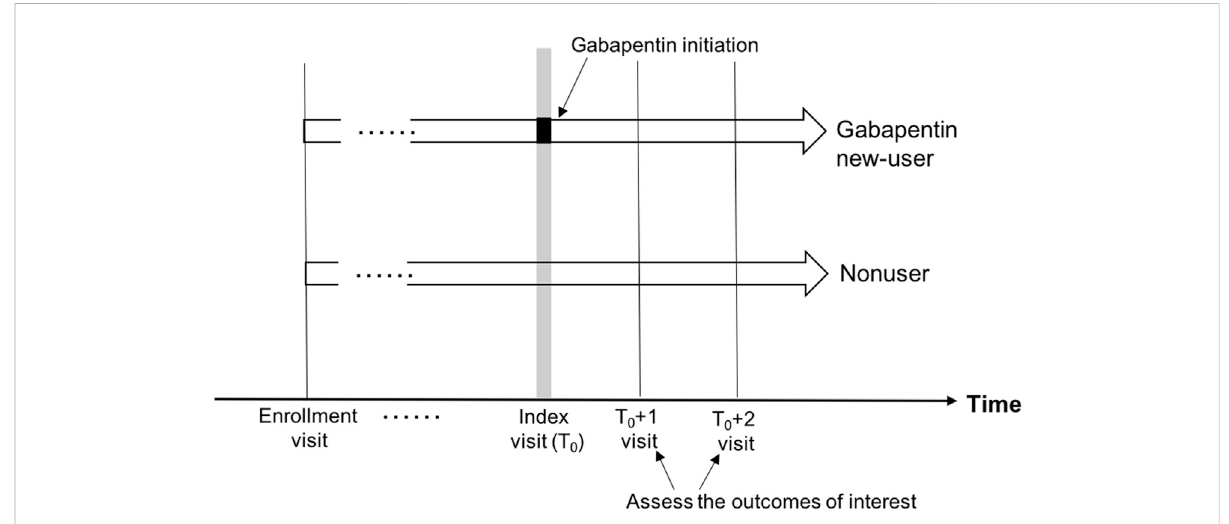
FIGURE 2 Depiction of study design comparing gabapentin initiators and nonusers.